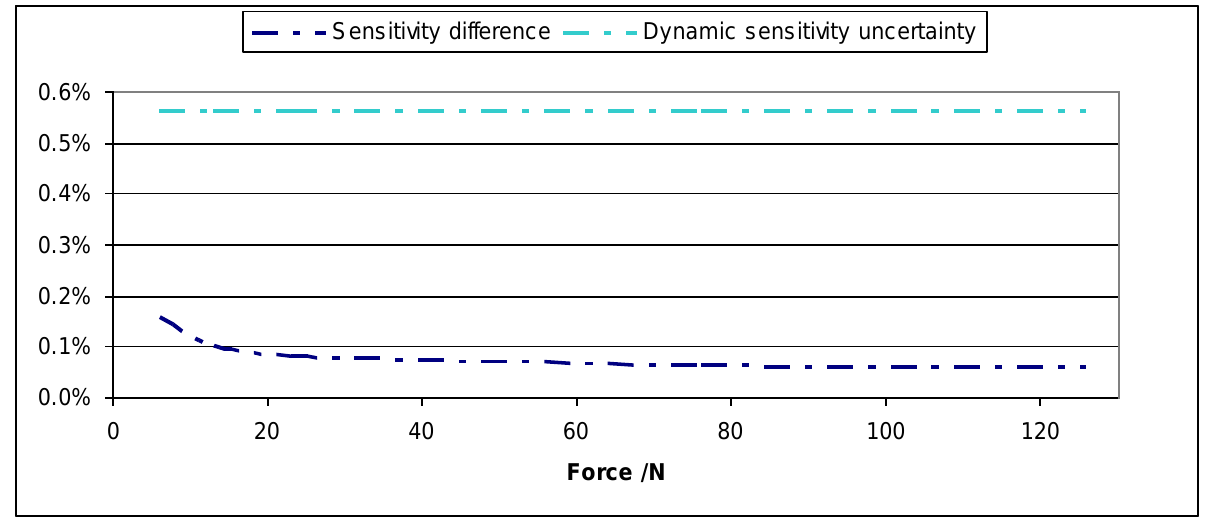
Figure 14. One curve represents the sensitivity difference between static and dynamic calibration and the other curve represents the dynamic sensitivity uncertainty versus applied force for the Interface 1610